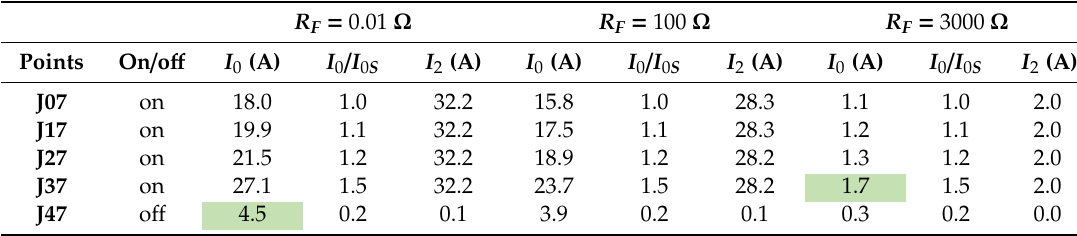
Table 1. Sequence currents at various point during earth fault